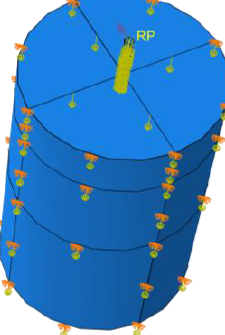
Figure 6. The 3-D FE model after completion of loading.